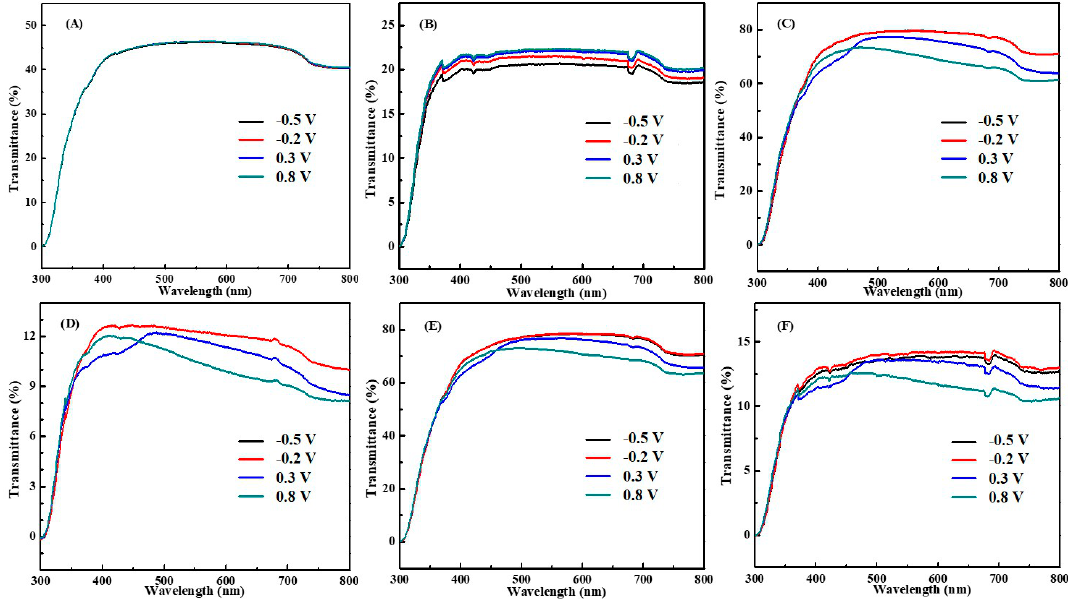
Figure 4. UV-vis spectra of ( A ) pure WO 3 film, ( B ) double layer WO 3 /graphene film, ( C ) pristine PANI film, ( D ) double layer graphene/PANI film, ( E ) double layer WO 3 /PANI film, and ( F ) triple layer WO 3 /graphene/PANI film in 0.5 M H 2 SO 4 aqueous solution at different potentials as − 0.5, − 0.2, 0.3, and 0.8 V.